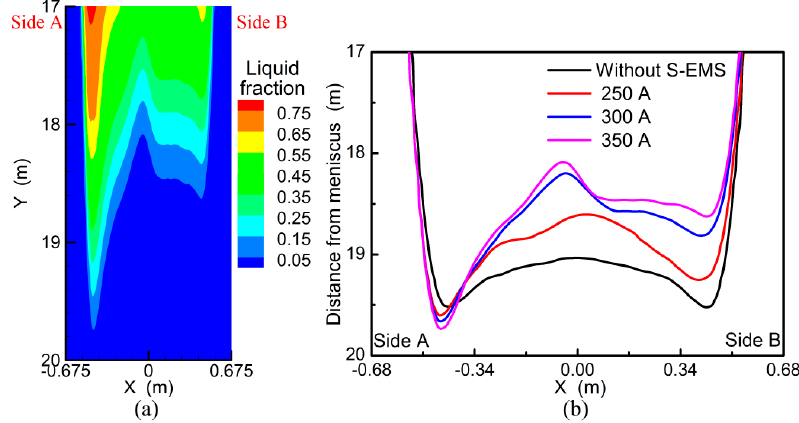
Figure 8. Liquid fraction in the longitudinal section with current intensity set at 350 A ( a ), and solidification end profile along the transverse direction ( b ).